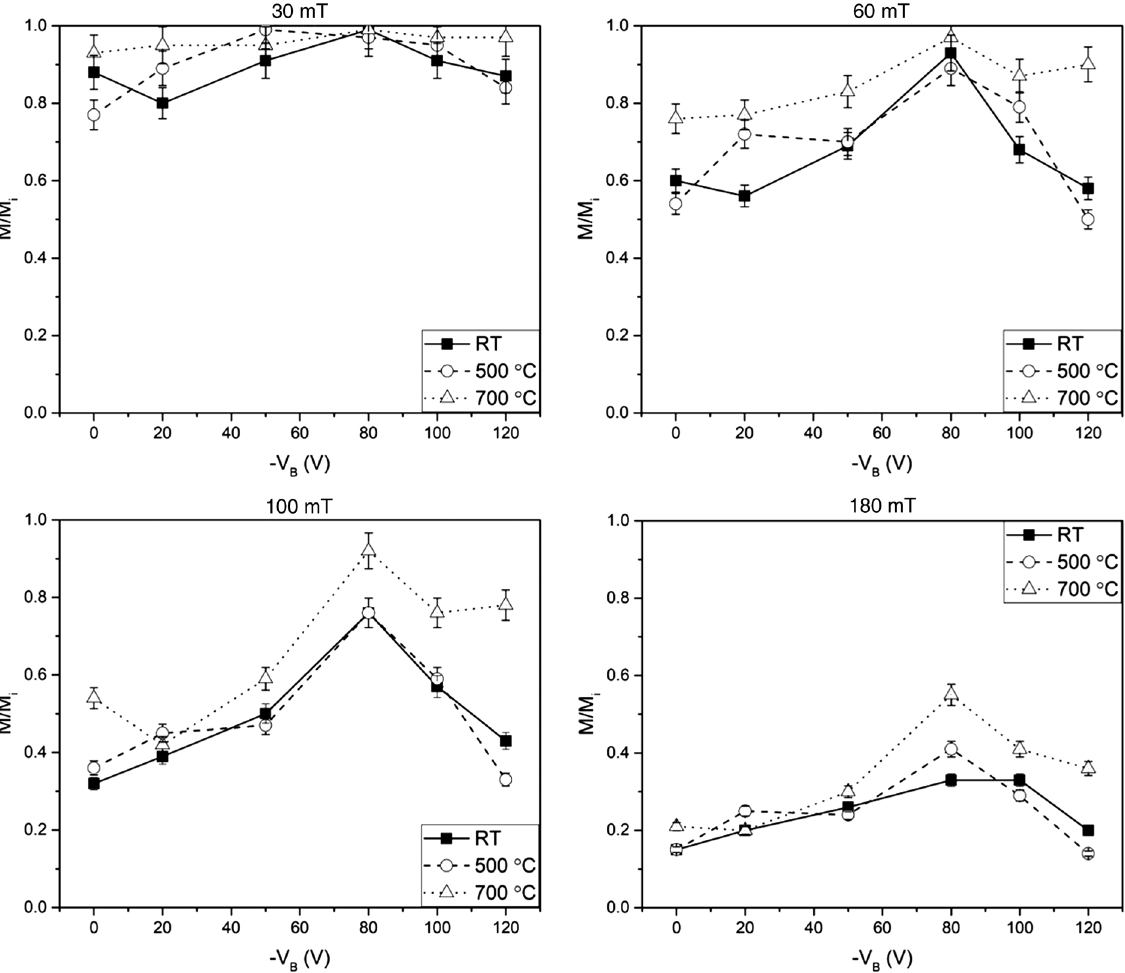
FIG. 9. Compilation of the measured M = M i for every sample at magnetic fields of 30, 60, 100 and 180 mT. The bias voltage applied to each sample is denoted as − V B ð V Þ